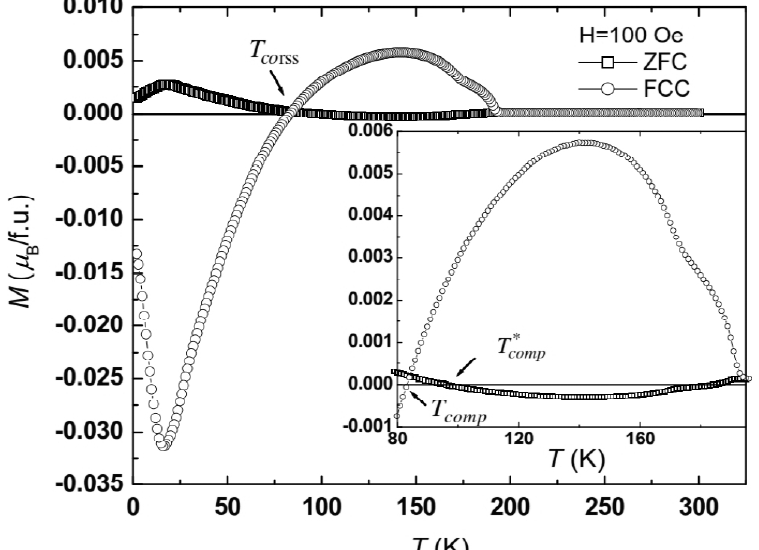
Fig. 7. Temperature dependent magnetization curves at an applied field of 100 Oe under ZFC and FCC for SmCr Mn O . The inset shows an magnifying part. Reproduced from [41] with permission from Springer. 0.9 0.1 3